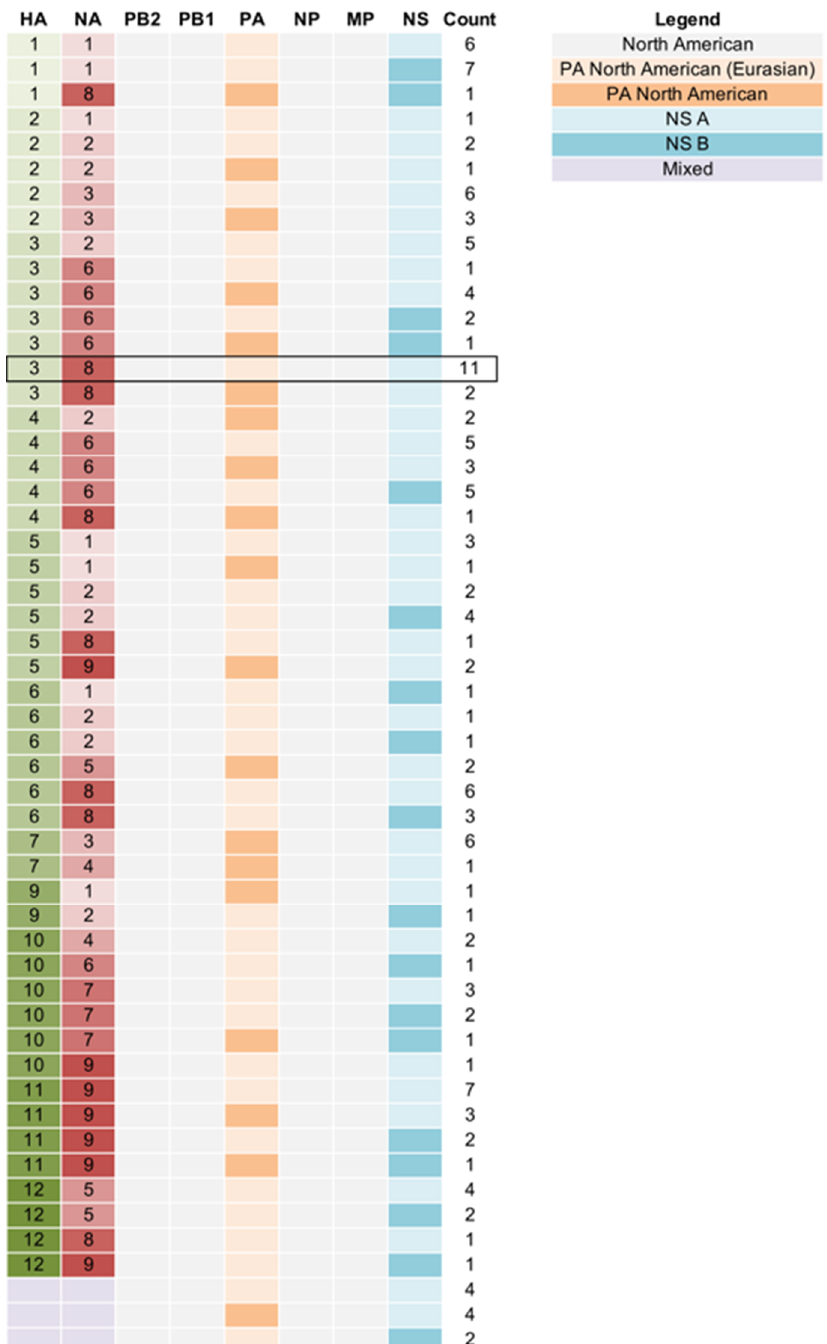
Figure 3. Genetic diversity of IAVs circulating in birds in Maryland. We identified 53 genotypes by surveillance of mallards in Maryland DHPs 2003–2013. Each rectangle represents 1 of the 8 segments of the virus genome. The two key surface antigens HA and NA are listed first, followed by the 6 remaining gene segments. Shading of each rectangle corresponds to major genetic lineages of (i) the HA and NA, which are sorted by subtype; (ii) the PA segment, which was classified into two North American lineages (North American and North American (Eurasian)); and (iii) the NS segment was sorted according to A and B alleles. All remaining internal segments were classified as belonging to a single North American lineage. Rectangles shaded purple represent mixed HA-NA infections. The black box indicates the most frequently observed genome constellation. The rightmost column indicates the number of viruses from each genotype identified in the DHPs.